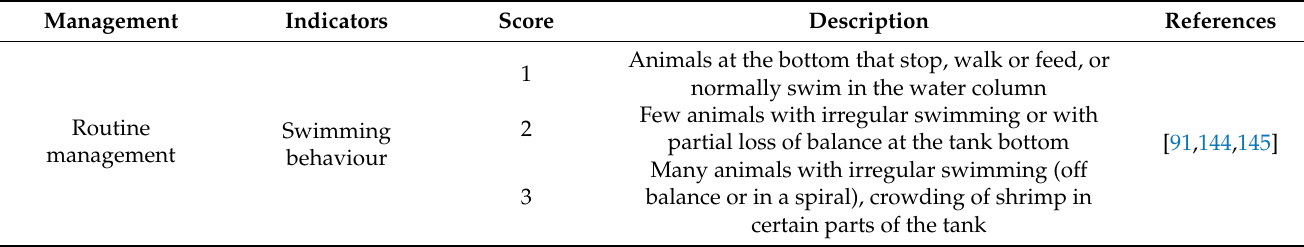
Table 5. Behavioural indicators for Penaeus vannamei